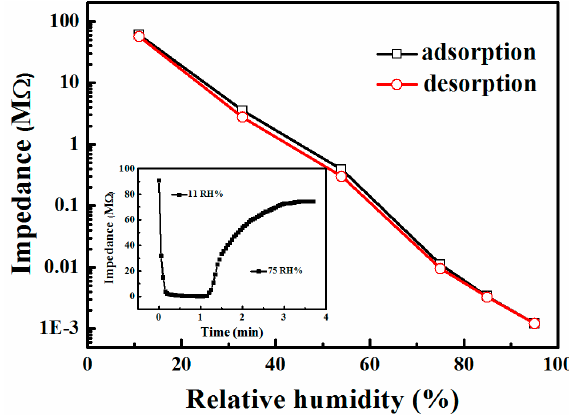
Figure 4. Humidity hysteresis characteristics of TiO 2 /SrTiO 3 sensor measured at 100 Hz and AC 1 V; Inset shows the response and recovery behavior of TiO 2 /SrTiO 3 humidity sensor.